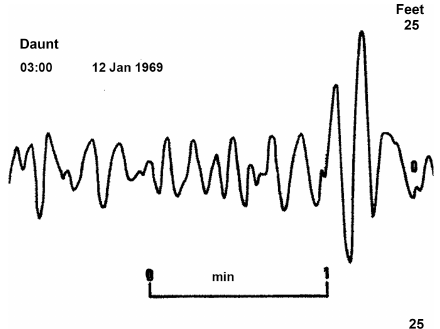
Figure 6. Wave recorder trace taken on 12 January 1969 (Fig. 1 in Draper